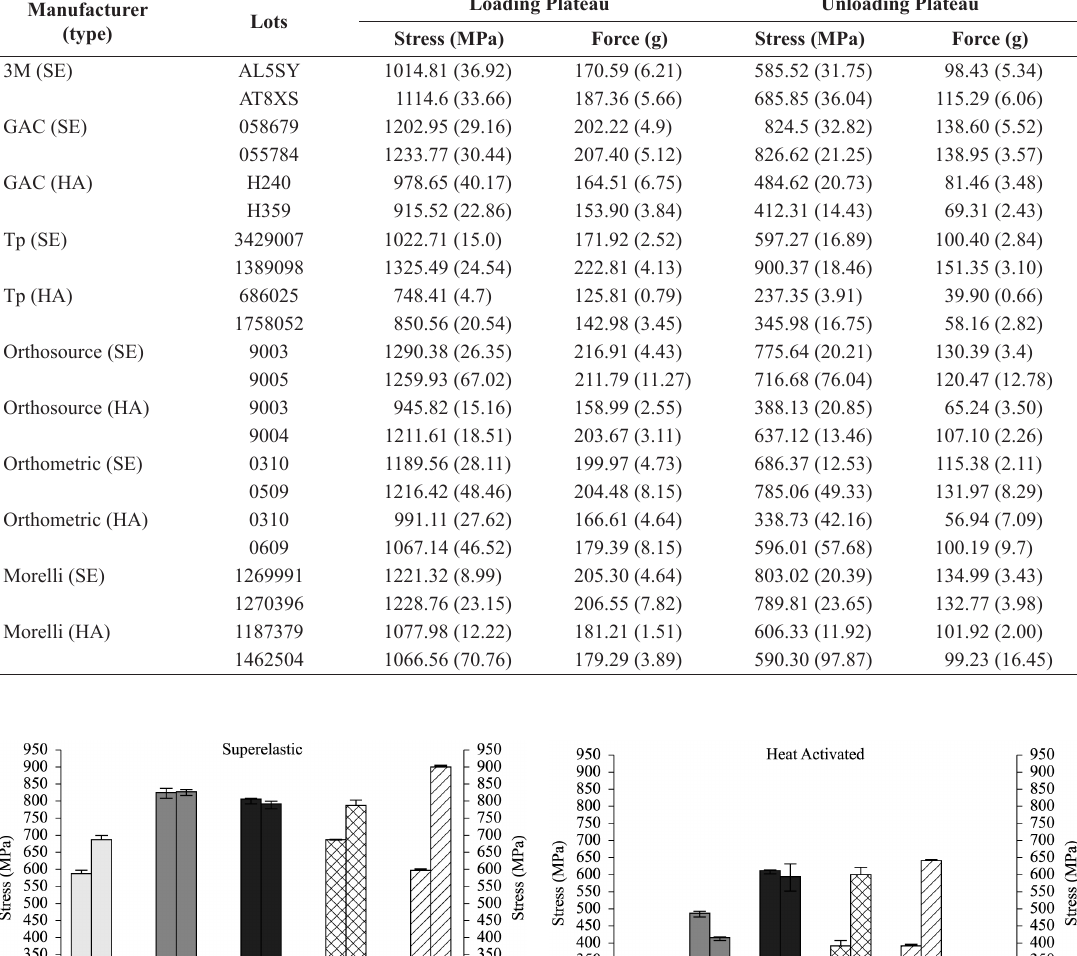
Table 2. Means (standard deviation) of loading and unloading stress (MPa) and force (g) for 3.1 mm deflection of superelastic (SE) and heat-activated (HA) NiTi 0.014-in inch orthodontic archwires. Manufacturer (type)